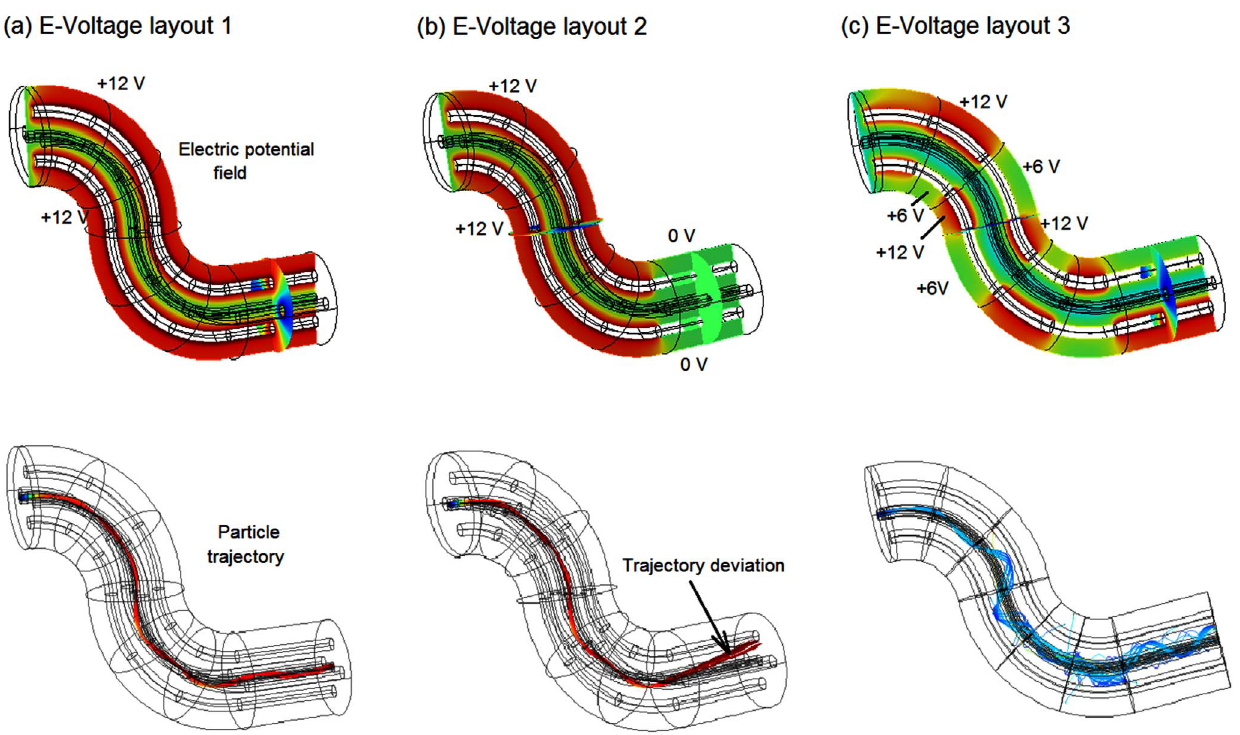
Figure 2. Electric field and particle trajectories within the quadrupole geometry with three electrode voltage layouts: (a) layout 1, (b) layout 2, and (c) layout 3.